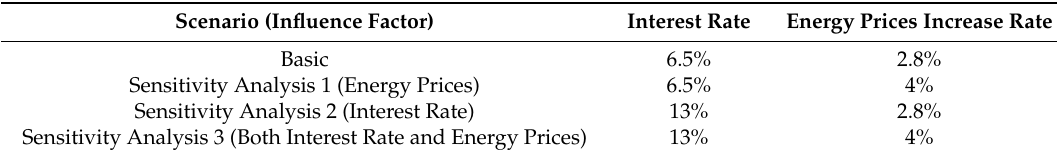
Table 5. Financial calculation scenarios based on influence